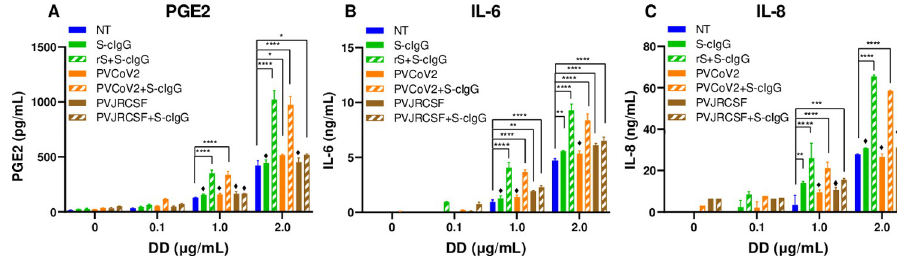
Fig 4. DD enhanced production of PGE2, IL-6, and IL-8 in monocytes activated with IC of SARS-CoV-2 pseudovirus coated with anti-CoV-2 spike MAb. (A-C) Monocytes were left not treated (NT) or were incubated with S-cIgG, with IC rS+S-cIgG, with PVCoV-2, with IC PVCoV-2+S-cIgG, with PVJRCSF, or with IC PVJRCSF+S-cIgG alone or in the presence of DD. Cell culture supernatants were collected and PGE2 (A), IL-6 (B) and IL-8 (C) concentrations were determined by FRET assay (A) and by ELISA (B, C). Mean PGE2 and IL-6, and IL-8 concentrations ± SD calculated for triplicate wells are shown for a representative of three experiments performed with cells from individual donors. � P � 0.03, �� P � 0.01, ��� P � 0.001, ��� P � 0.0001, by two-way ANOVA using Tukey’s multiple comparison test; ♦ , no significance (ns) compared with NT.